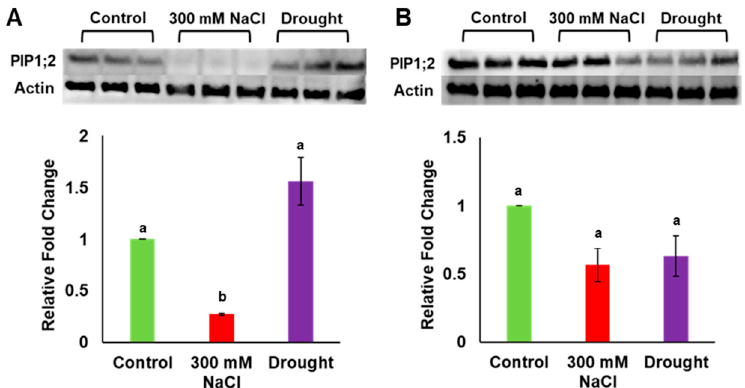
Figure 4. Analysis of PdPIP1;2 protein expression in leaf and root tissues under drought and salinity conditions. Protein immunoblot image showing the levels of PdPIP1;2 protein accumulation in leaves ( A ) and roots ( B ) of date palm seedlings, grown under control, salinity and drought conditions of three biological replicates. The bar graph shows the mean of the relative fold change of accumulation (± SE, n = 3) in salinity and drought stress, compared to control conditions. Asterisks indicate a significant difference at p < 0.05.